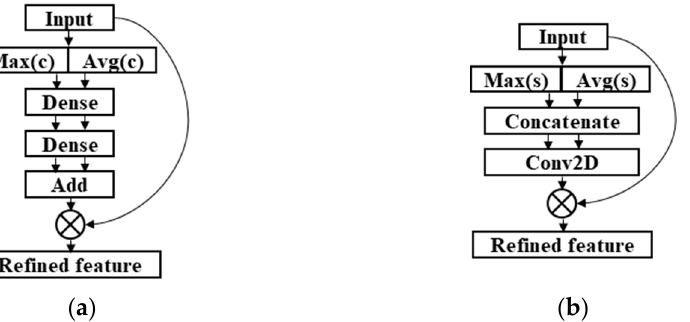
Figure 6. Structures of the attention modules. ( a ) Channel attention module. ( b ) Spatial attention module.